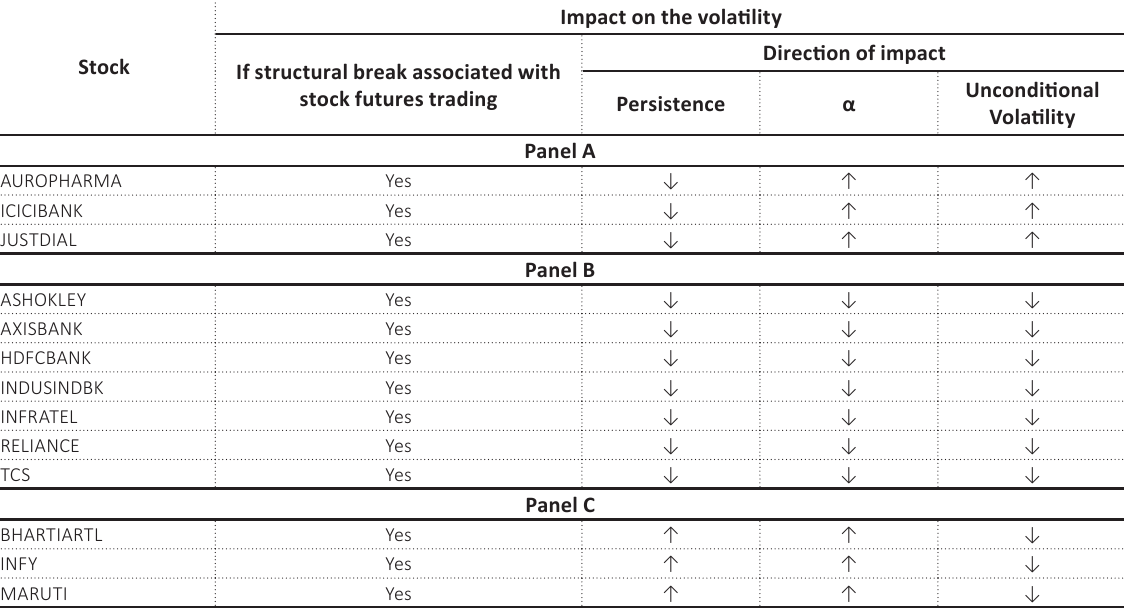
Table 4. Impact of stock futures on the volatility of underlying stocks